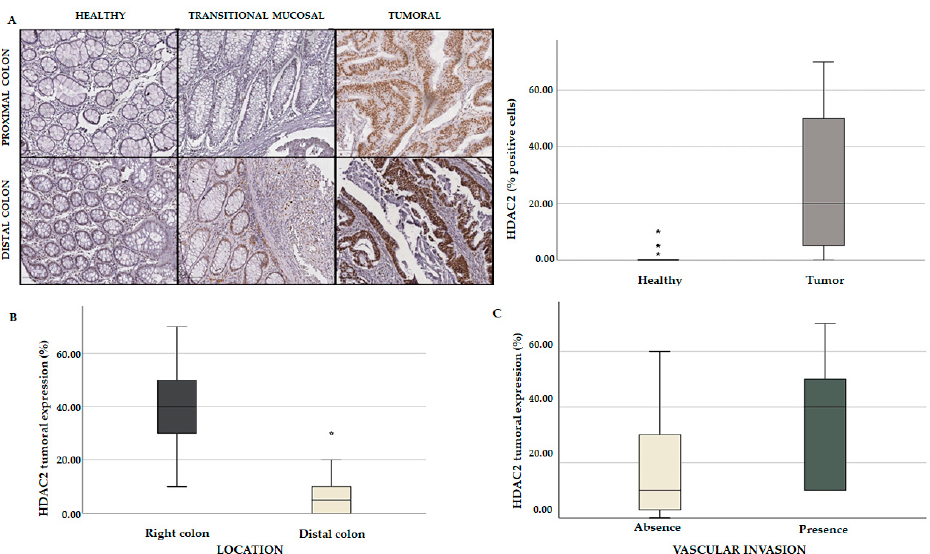
Figure 10. Comparative analysis of TMA containing a cohort of CRC patients. ( A ) Immunohisto- chemical (IHC) analysis showing HDAC2 expression in healthy, tumoral, and transitional mucosal tissues ( p = 0.01); HDAC2 tumoral expression based on colon localization ( p = 0.001) ( B ) and vascular invasion ( p = 0.041) ( C ). Each value that deviates from the central trend of the distribution is represented in the graph with the symbol *. Values that come out of the whiskers, i.e., that are further from the box by more than 1.5 * interquartile range (IQR) up or down, are considered potential outliers and represented with symbol.